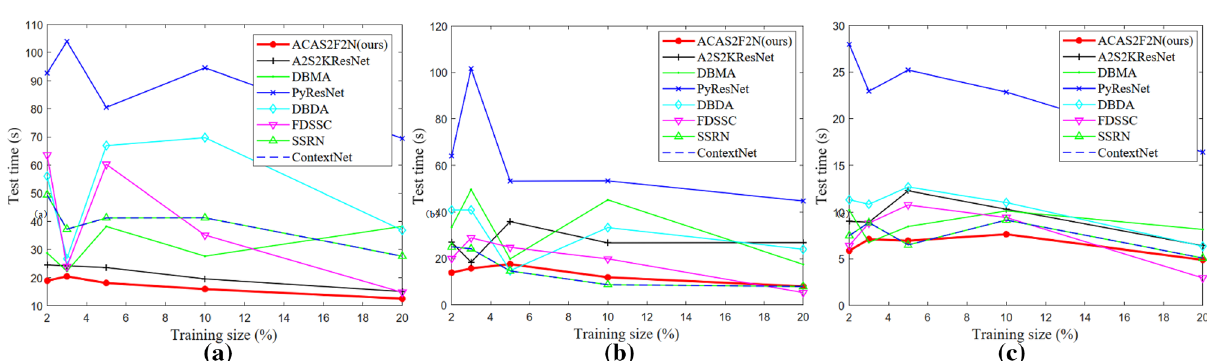
Figure 10. Training time under different training sizes. ( a ) IP dataset. ( b ) KSC dataset. ( c ) Botswana dataset.